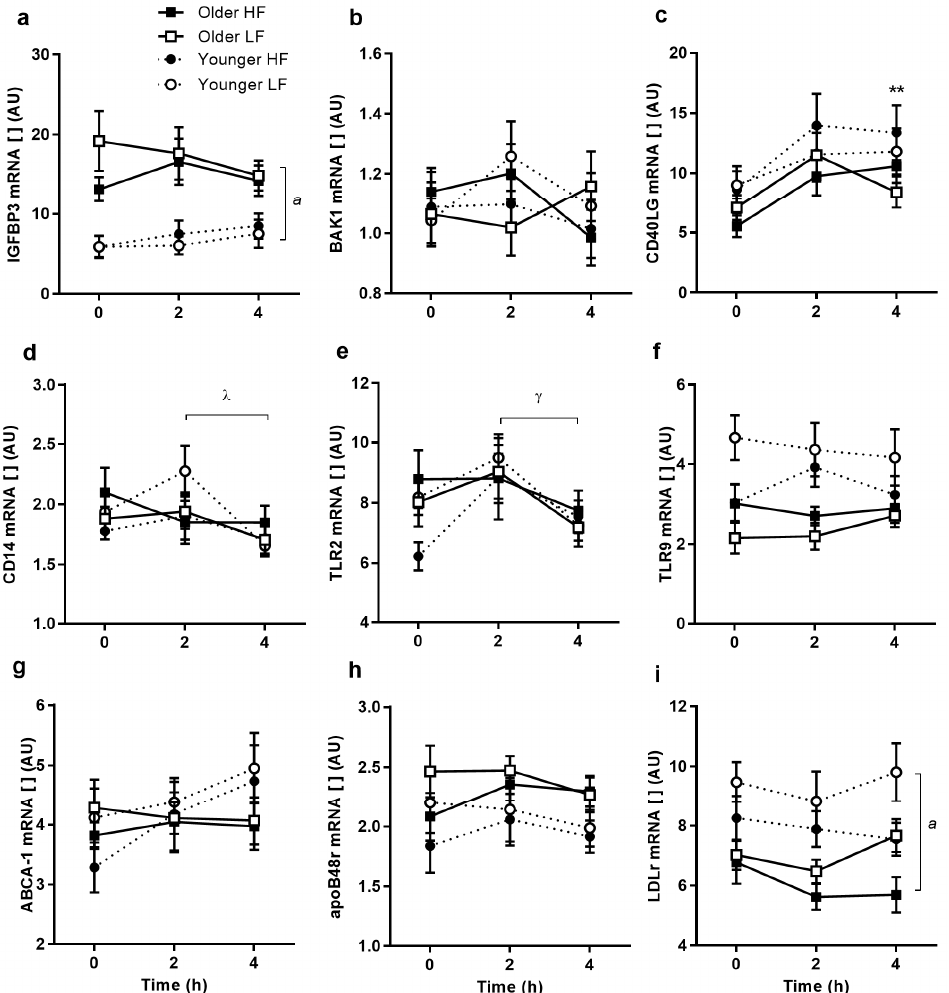
Figure 3. Relative senescence-related, endotoxaemia-related and lipid receptor peripheral blood mononuclear cells (PBMC) gene expression responses to high-fat (HF) and low-fat (LF) breakfasts in older and younger subjects. Older high-fat ( filled squares ), older low-fat ( open squares ), younger high-fat ( filled circles ), younger low-fat ( open circles ). Values represent mean ± SEM ( n = 15/group) in arbitrary units (AU) for IGFBP3 ( a ), BAK1 ( b ), CD40LG ( c ), CD14 ( d ), TLR2 ( e ), TLR9 ( f ), ABCA-1 ( g ), ApoB48r ( h ), and LDLr ( i ), respectively. There were no differences in BAK1 TLR2, TLR9, ABCA-1, or ApoB48r responses between older and younger adults. There were significant age differences in LDLr gene expression (age effect of p < 0.05) and changes over time for CD40LG and TLR2 (time effect of p < 0.05 and p < 0.01, respectively). There were significant age differences and time differences, dependent on treatment in the IGFBP3 response (time × treatment interaction of p < 0.01, age effect of p < 0.01, three-factor repeated-measures ANOVA). CD14 expression was significantly different between older and younger adults over time (time × age interaction of p < 0.05). a p < 0.05 main age difference; ** p < 0.01 change from baseline; λ p < 0.05 time difference in younger subjects; γ p < 0.01 time difference (Sidak corrected post hoc